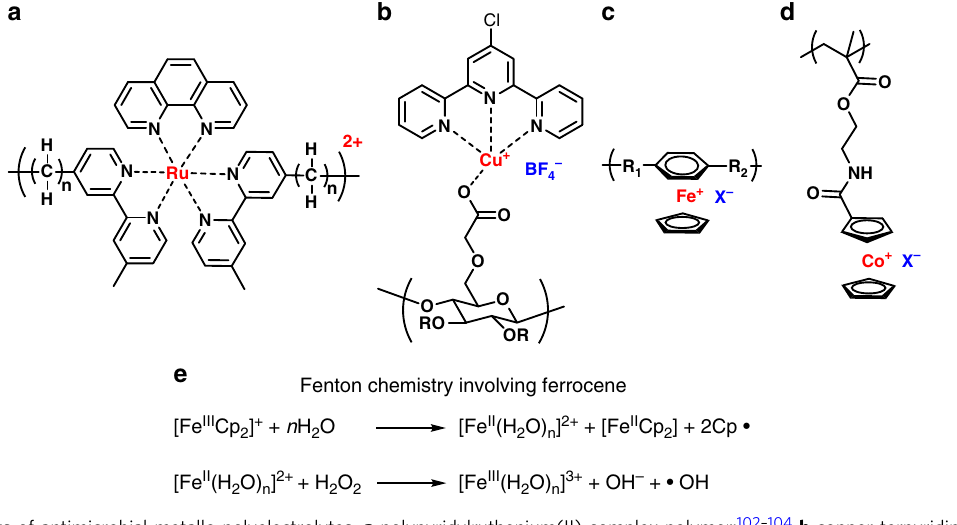
Fig. 5 Structural units of antimicrobial metallo-polyelectrolytes. a polypyridylruthenium(II) complex polymer; 102 – 104 b copper-terpyridine